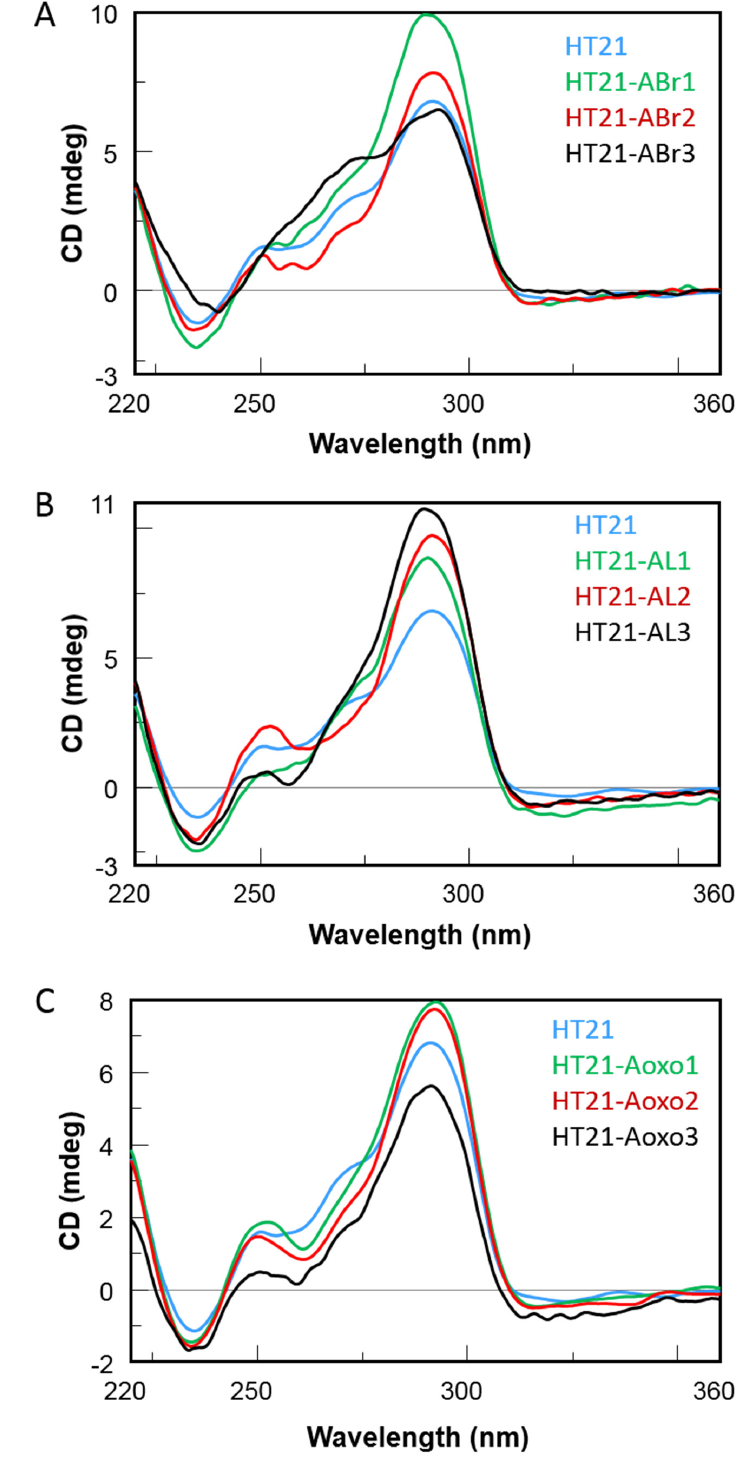
Figure 3. CD spectra of HT21 and its A Br (Panel A ), A L (Panel B ) and A oxo (Panel C ) derivatives in 20 mM MOPS buffer (pH 7.0) containing 150 mM KCl (20 µM in ODN).